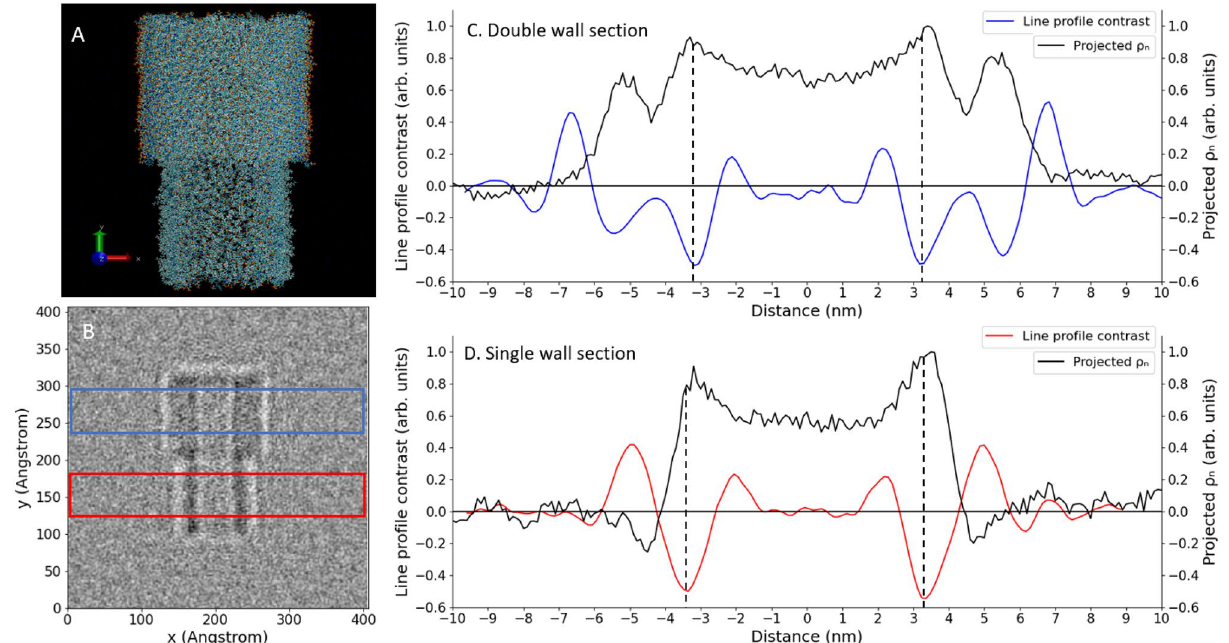
Figure 5. Molecular model of C8S3 NTs ( A ), simulated HRTEM image at defocus of 1.2 µm ( B ) and averaged- contrast line profiles of DW (blue) ( C ) and SW (red) ( D ) sections along with their respective projected nuclear charge densities (ρ n ). The molecular model ( A ) and simulated HRTEM image ( B ) show both DW and SW sections, which are highlighted in the latter by blue and red rectangles, respectively. Five line profiles of 20 nm each from the simulated HRTEM image are averaged and smoothened by taking a rolling average over seven points ( C , D ). The line profiles (projected nuclear densities) are normalised to a minimum (maximum) value of −0.5 (+ 1) for the ease of comparison. In panels ( C ) and ( D ), the dashed lines show the positions of the inner dips ( ∼ ± 3.5 nm) of the line profiles, which are reasonably close (within 0.5 nm) to the positions of the inner maxima of the projected nuclear